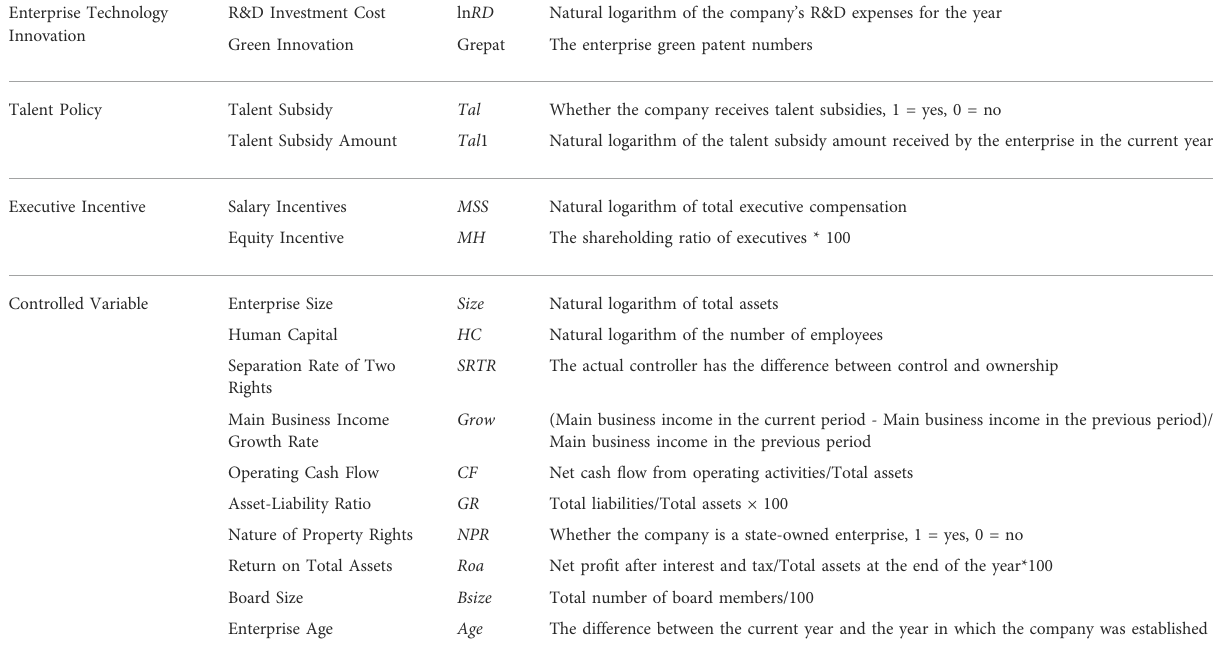
TABLE 1 Variable names and descriptions.